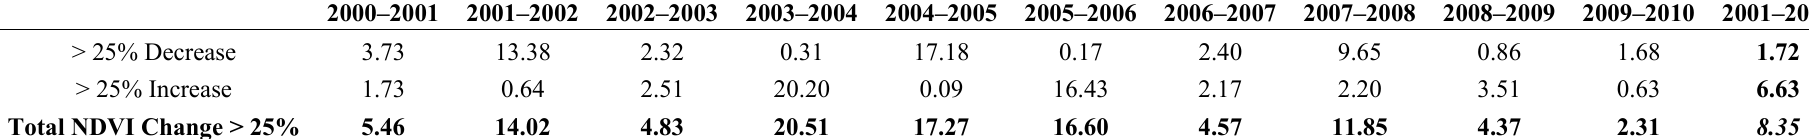
Table 2. Two-date standardized growing season NDVI change detection in percent of total Chobe Basin area from 2000 to 2010 based on moderate resolution imaging spectroradiometer (MODIS) growing season NDVI data (in red, statistically significant decreases; in green, statistically significant NDVI increases; statistical significance tested using the Student’s t -test at the 95% confidence level).